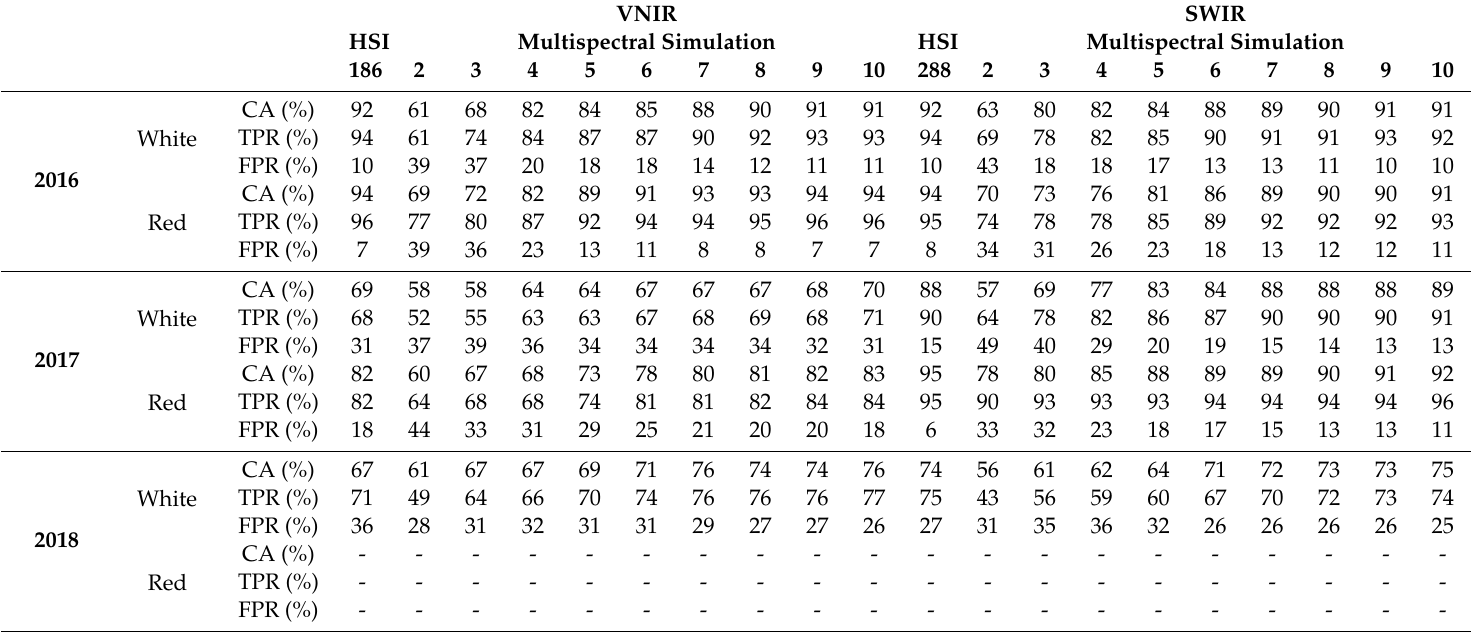
Table A3. Results of the multispectral simulation for GLRaV-3 symptom